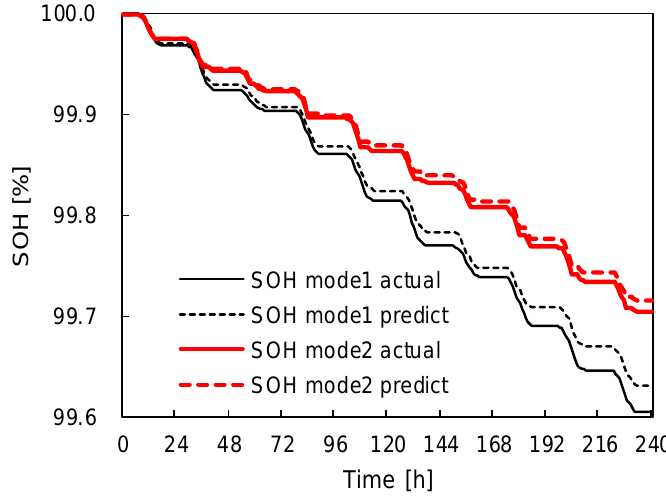
Figure 4. Comparison of the day-ahead battery degradation estimations.